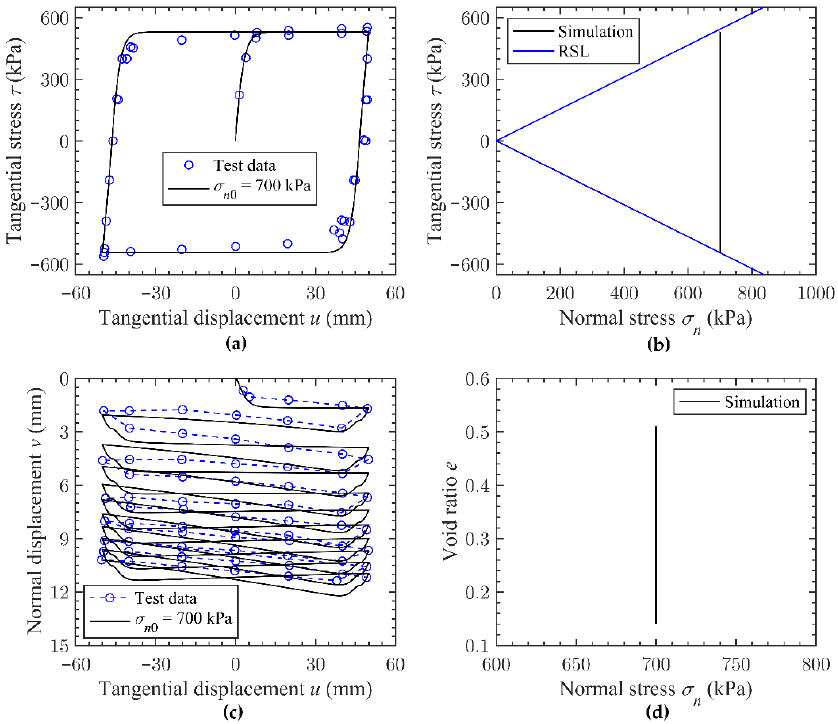
Figure 3. Zipingpu rockfill-steel interface [11] under CNL: ( a ) Tangential displacement v.s. tangen- tial stress; ( b ) Normal stress v.s. tangential stress; ( c ) Tangential displacement v.s. normal displacement; ( d ) Normal stress v.s. void ratio.